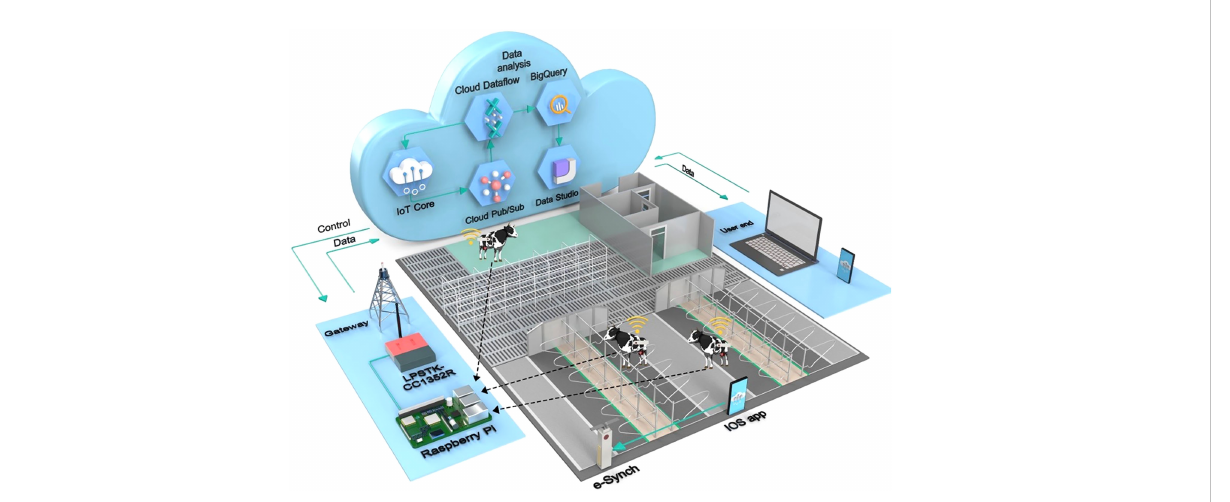
FIGURE 1 Conceptual framework of the proposed e-Synch system. The e-synch device with drug delivery and sensing capabilities is controlled and monitored by a smartphone or smart device IOS application (app) through Bluetooth communication. The app allows the user to select pre-established synchronization of ovulation protocols or customize a protocol. Once programmed to schedule hormone release, activated, and inserted in the cow vagina, hormones are released according to the selected protocol or customized sequence and hormone quantity selected by the user. Sensor information is sent through 915 MHz RF to the gateway connected to Raspberry PI 3 through a UART connection. The gateway uploads all information to the Google Cloud utilizing the IoT Core service through TCP/IP. Data published to the IoT core are pulled by the Pub/Sub service, which is routed to the BigQuery table by the Data fl ow service. Data Studio utilizes the BigQuery table for visualization. Data on the server is used by the application end for device monitoring and data